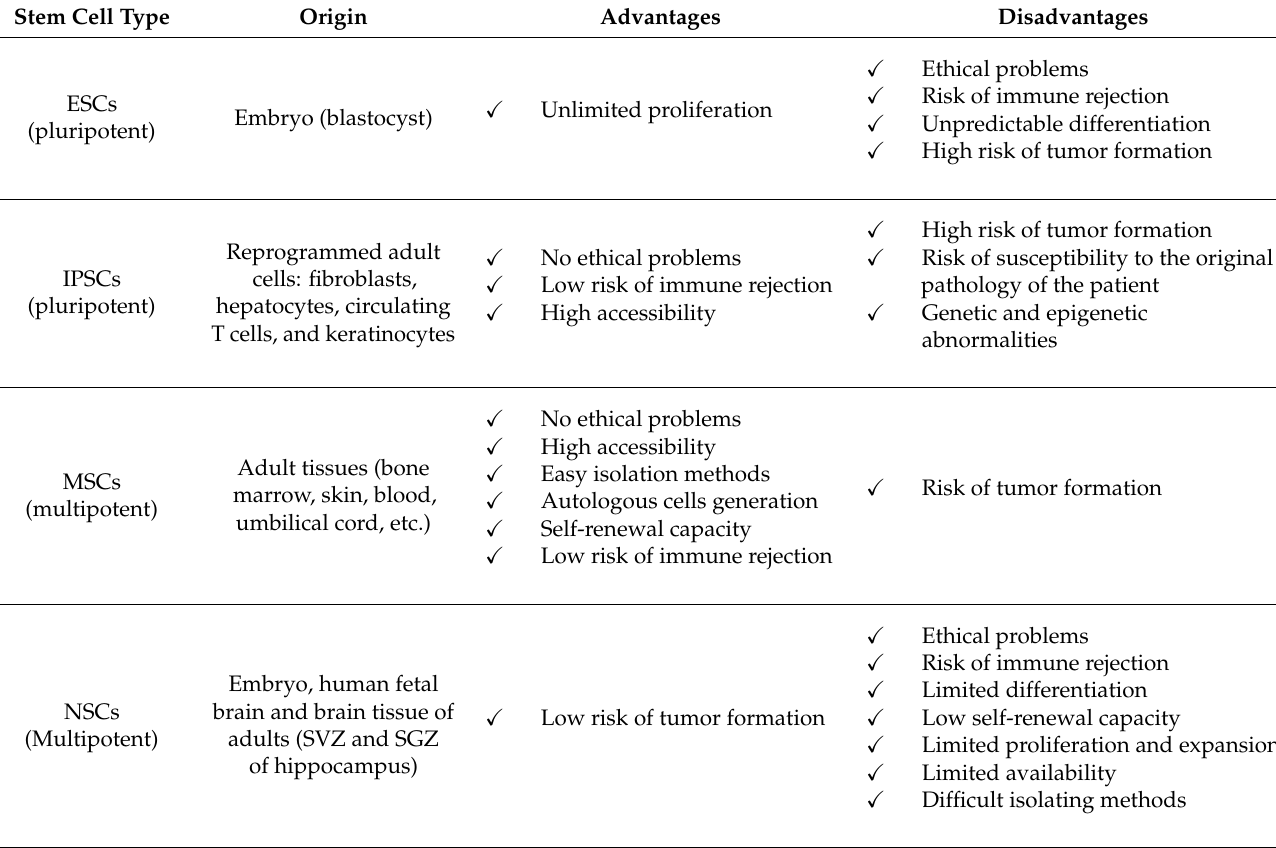
Table 1. Comparison between the various types of stem cells. This side-by-side comparison includes their origin and the inherent clinical advantages and disadvantages of using these